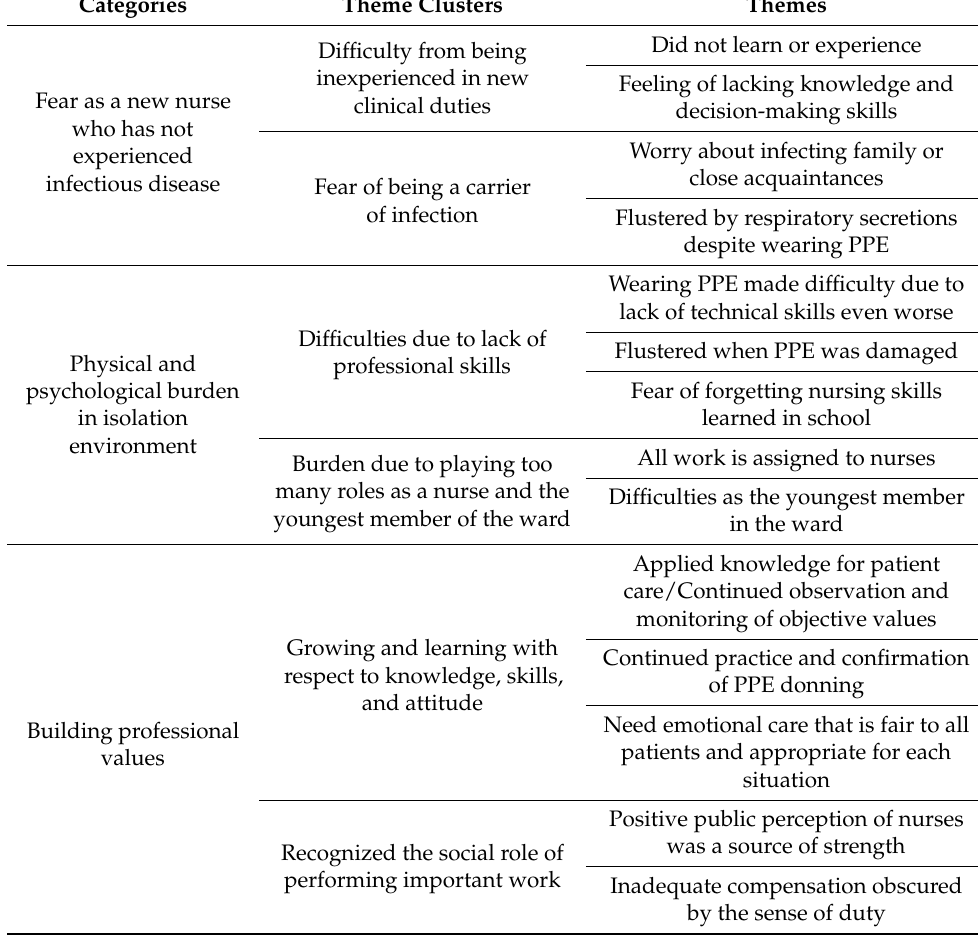
Table 1. Themes, Theme clusters and Categories of the